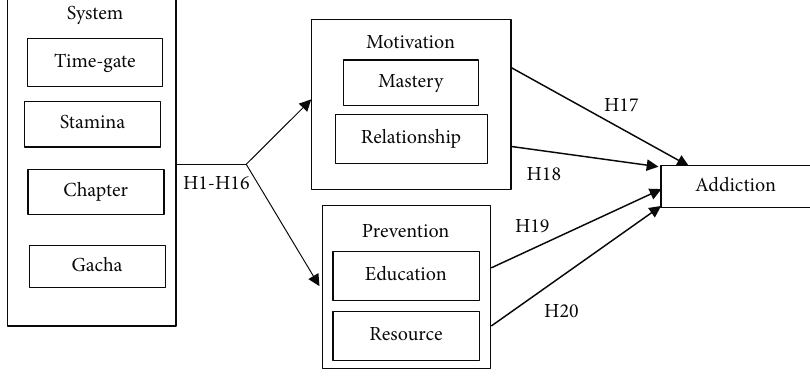
Figure 2: Research